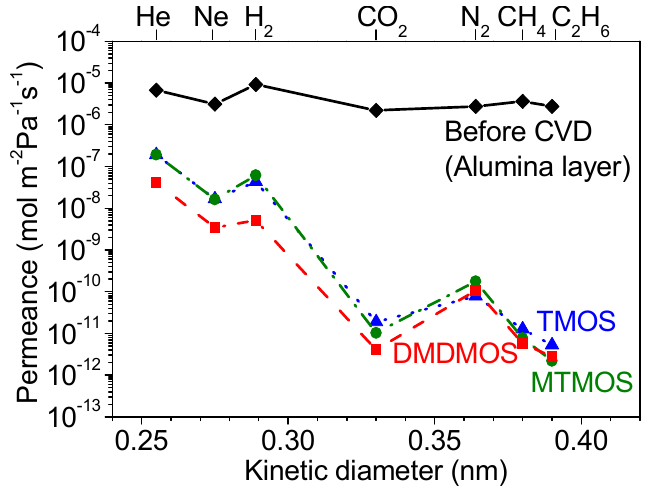
Figure 6. Gas permeances at 300 °C through the ( ◆ ) alumina intermediate layer, ( ▲ ) TMOS-, ( ● ) MTMOS-, and ( ■ ) DMDMOS-derived membranes.